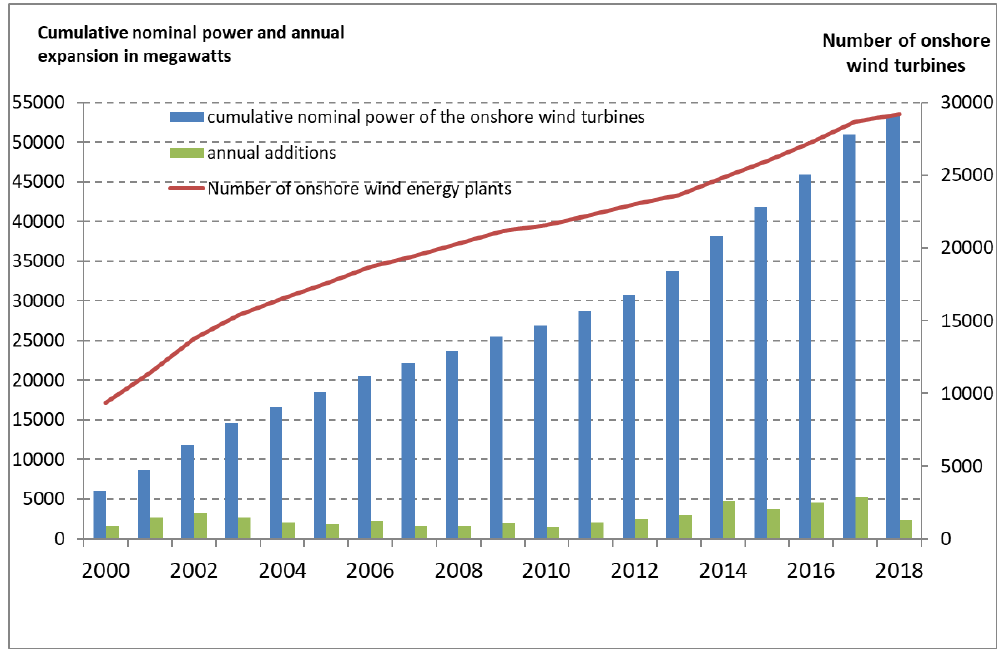
Figure 4. Number of onshore wind turbines, the cumulative nominal power, and annual additions of wind turbines in Germany from 2000 to 2018 [5], own illustration.